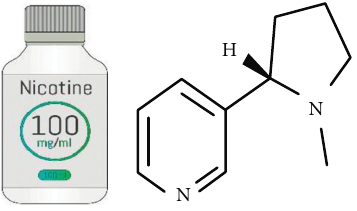
Figure 3: Graph structure of nicotine. Table 5: Atoms dataset of the graph structure of nicotine.